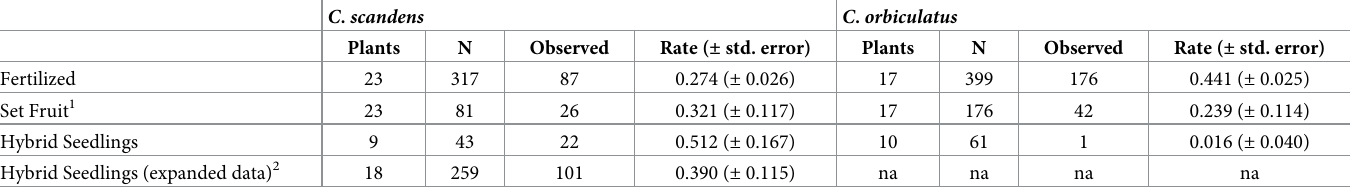
Table 2. Fate of open-pollinated pistillate